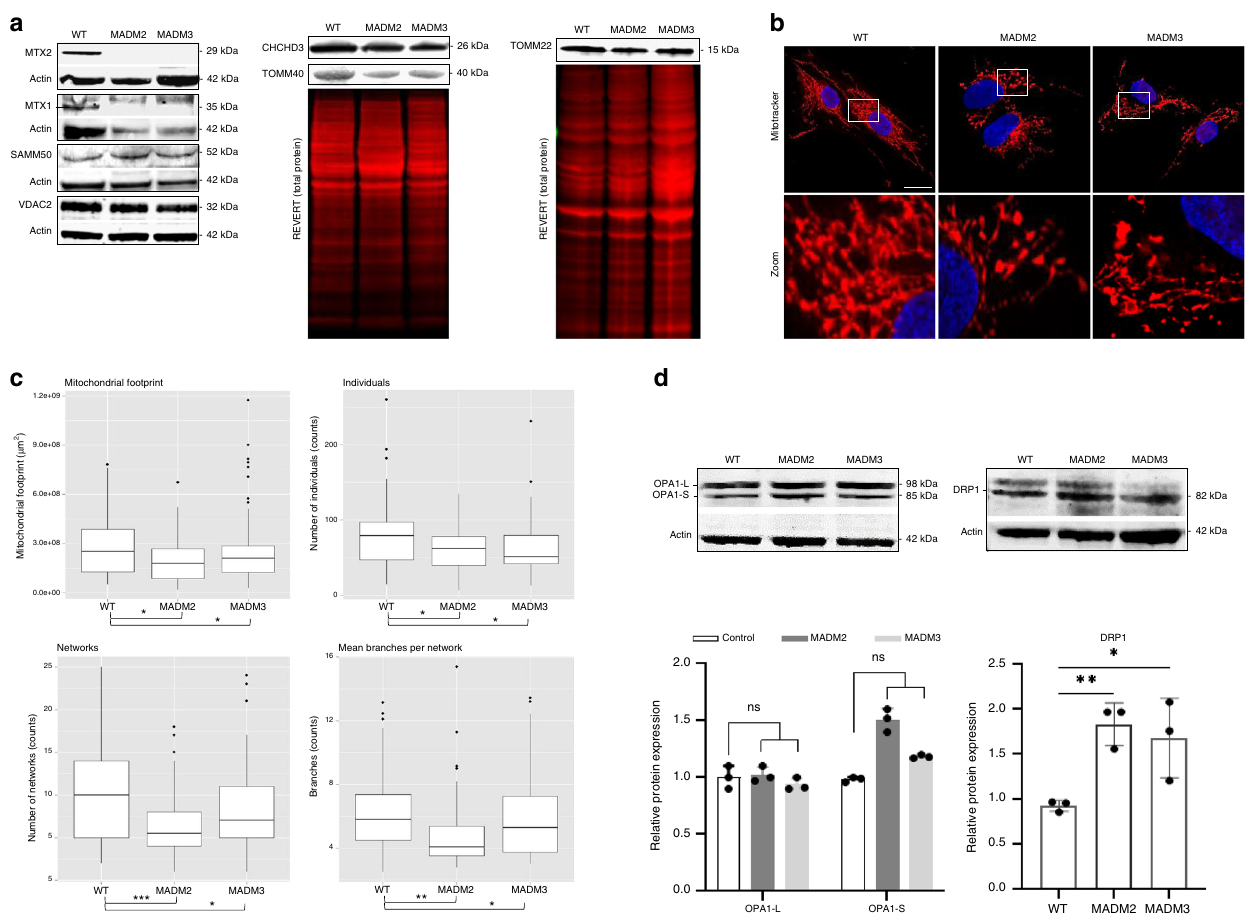
Fig. 2 MTX2 de fi ciency induces altered mitochondrial protein composition and increased mitochondrial fi ssion. a Immunoblot analysis of MTX2 and other outer and inner mitochondrial membrane proteins of whole-cell extracts from healthy control (WT) and patients ’ (MADM2, MADM3) fi broblasts. Actin or REVERT total proteins were used as loading controls. n = 3 independent experiments for MTX2, TOMM22, SAMM50, CHCHD3 and n = 2 independent experiments for MTX1, VDAC2, TOMM40. b Representative confocal microscopy images showing mitochondria stained using DAPI (blue) and Mitotracker (red) from a control, patient MADM2, and patient MADM3. Boxed regions are enlarged. Scale bar: 10 µ m. Data shown are representative of ten independent experiments. c Mitochondrial network analysis using the MINA ImageJ macro of healthy and patients ’ fi broblasts showing signi fi cant differences in: mitochondrial footprint (exact p values: p MADM2 = 0.026, p MADM3 = 0.041), individuals ( p MADM2 = 0.013, p MADM3 = 0.042), networks ( p MADM2 = 7.31737E − 05, p MADM3 = 0.041) and mean number of branches per network ( p MADM2 = 0.005, p MADM3 = 0.043). 53 (WT), 46 (MADM2) and most extreme values within 1.5 times the interquartile range (vertical lines). Two-tailed unpaired t test; * p < 0.05, ** p < 0.01, *** p < 0.001. d Immunoblot analysis of OPA1-L (protein optic atrophy 1, long) and OPA1-S (protein optic atrophy 1, short) (proteins involved in mitochondrial fusion, OPA1-S being issued from cleavage of OPA1-L) and DRP1 (protein involved in mitochondrial fi ssion). Protein levels were quanti fi ed by ImageJ software and their expression levels were normalized to actin as an internal loading control. Results are expressed as mean ± SD, two-tailed unpaired t test was used to evaluate the statistical signi fi cance of differences among the groups (exact p values: OPA1-L: p MADM2 = 0.772, p MADM3 = 0.385; OPA1-S: p MADM2 =